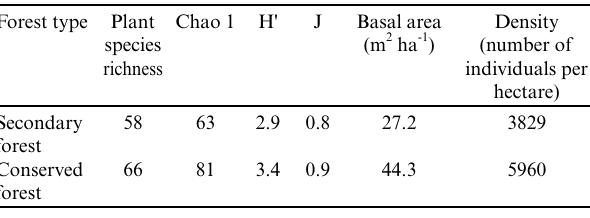
Table 1 . Diversity (H´= Shannon index, J = Pieulo´s index) and structural traits of vegetation at the El Tajín Archaeological Monument Zone,